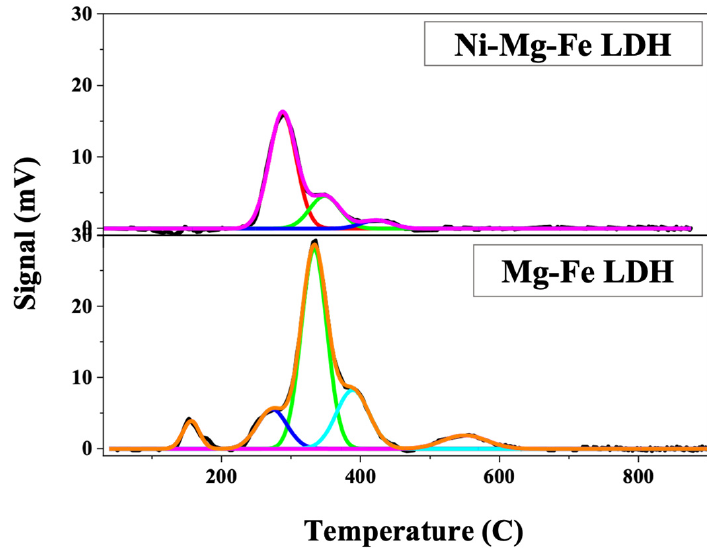
Figure 6. CO 2 -TPD patterns of the Mg-Fe LDH and Ni-Mg-Fe LDH catalysts. Table 2. Data obtained from the CO 2 -TPD profile analyses of all investigated samples. Table 2. Data obtained from the CO 2 -TPD pro fi le analyses of all investigated samples. Catalyst Temp. ( ◦ C) CO 2 Uptake ( µ Catalyst Temp. (°C)